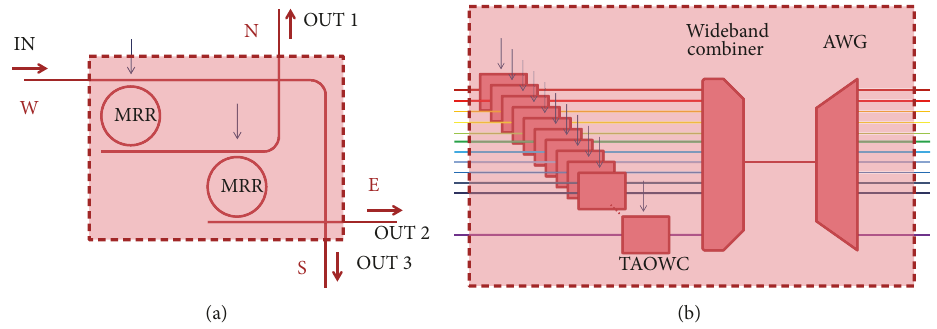
Figure 6: Structure of (a) switching module (SM); (b) wavelength converter array (WCA).